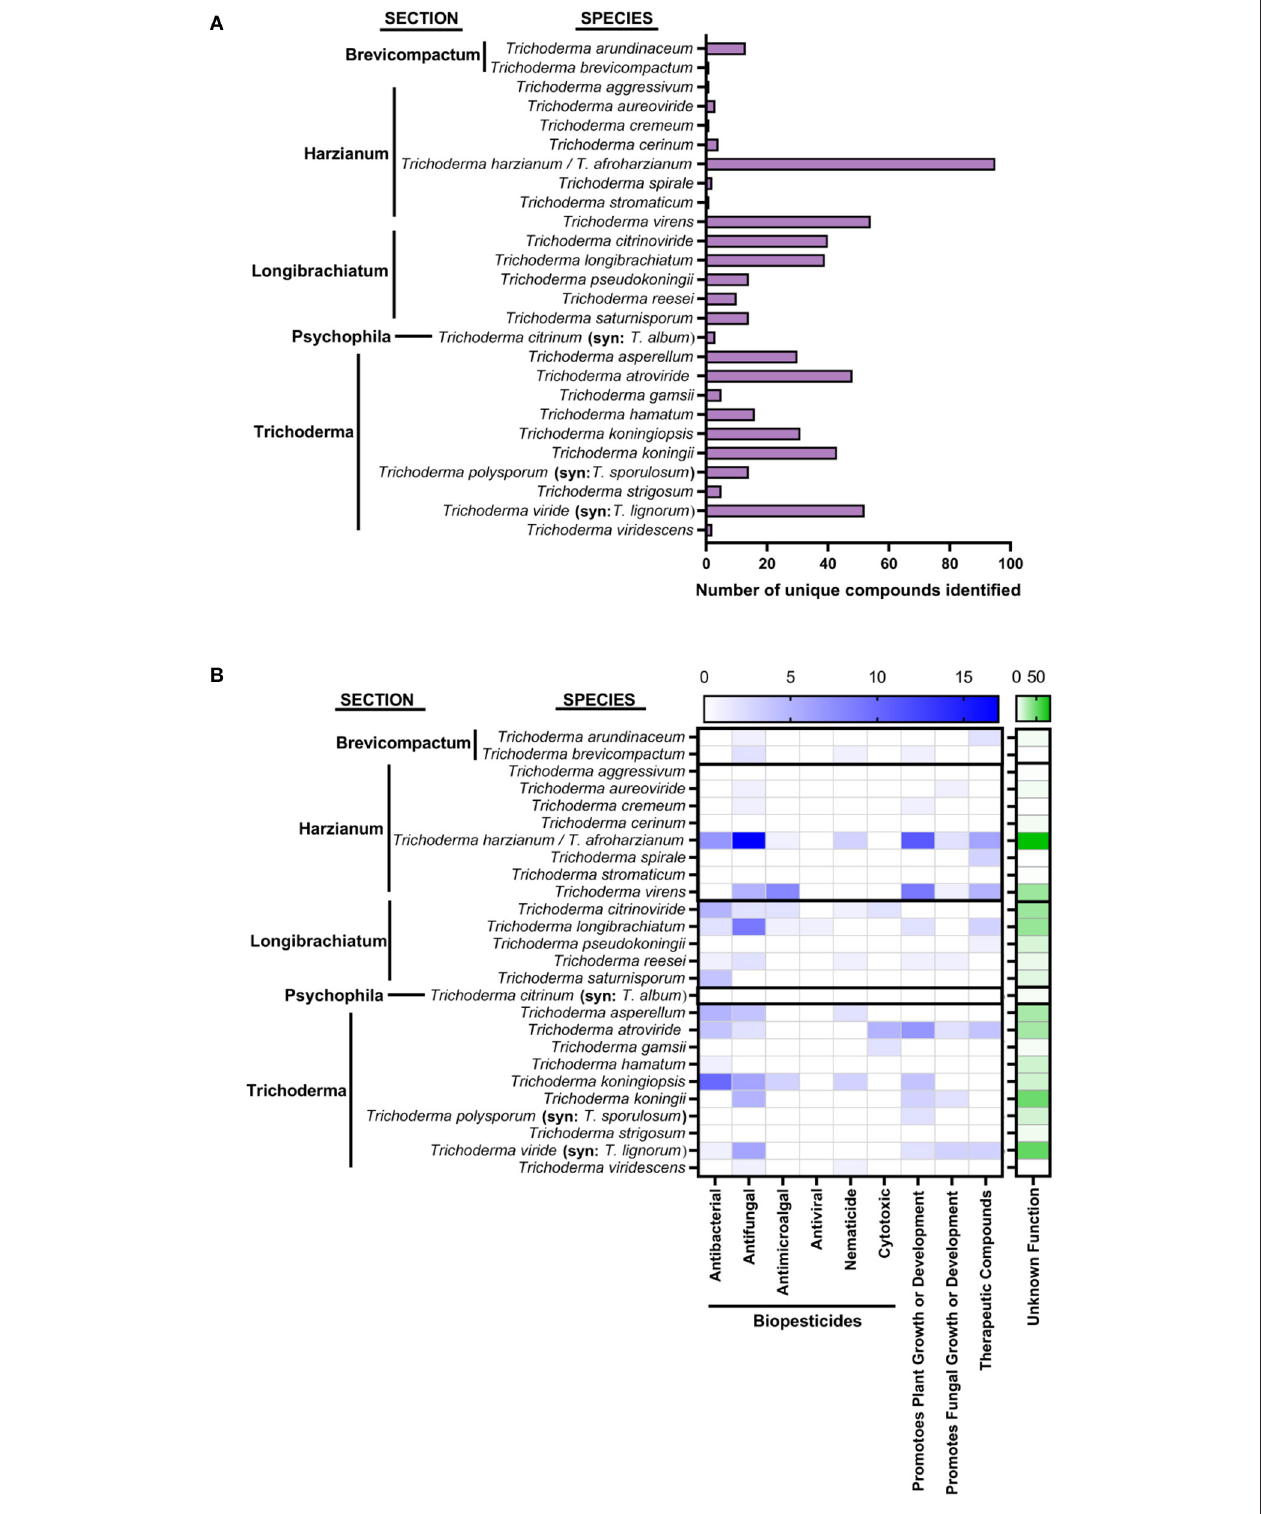
FIGURE 3 | Number of known compounds identified in Trichoderma species (A) Species of Trichoderma organized by section, showing the number of unique compounds identified. (B) Their bioactivity refers to metabolites’ activities. Metabolites with antibacterial, antifungal, antimicroalgal, antiviral, nematicide, and cytotoxic properties could be used as biopesticides. Metabolites that promote plant growth or development could be used as biofertilizers or biostimulants. Metabolites that promote the fungus’ own growth and development have no assigned category. Therapeutic compounds have been identified for their potential use in the medical